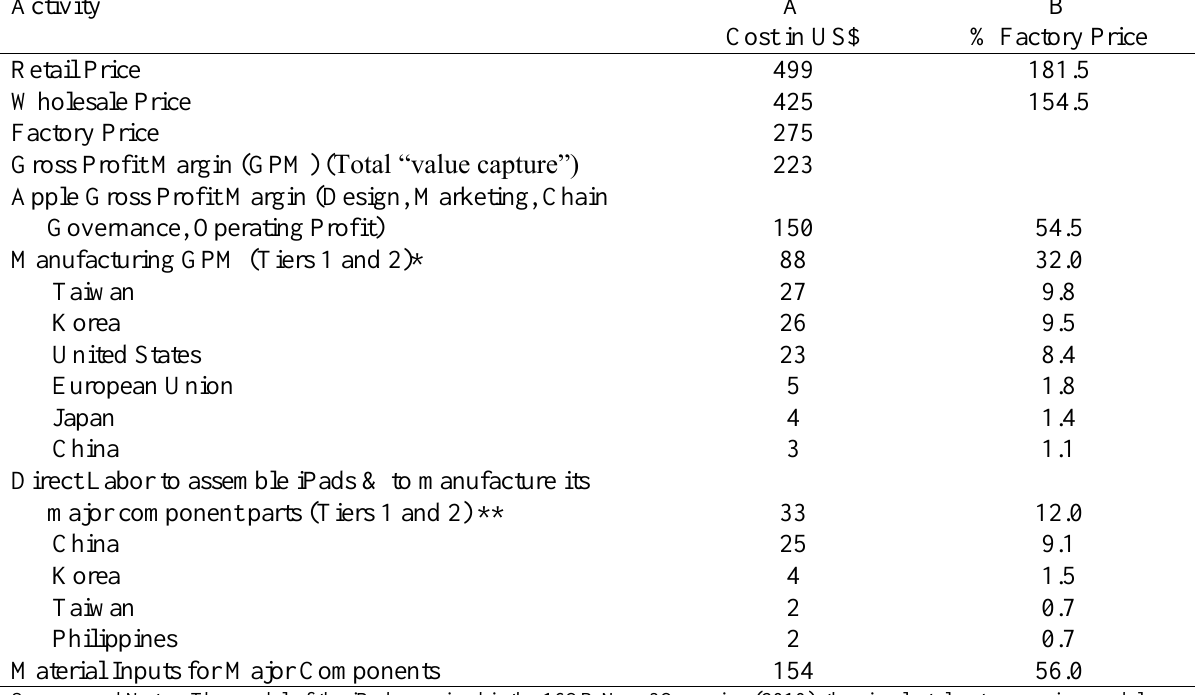
Table 1. Flow of Bright Value in the iPad Commodity Chain,